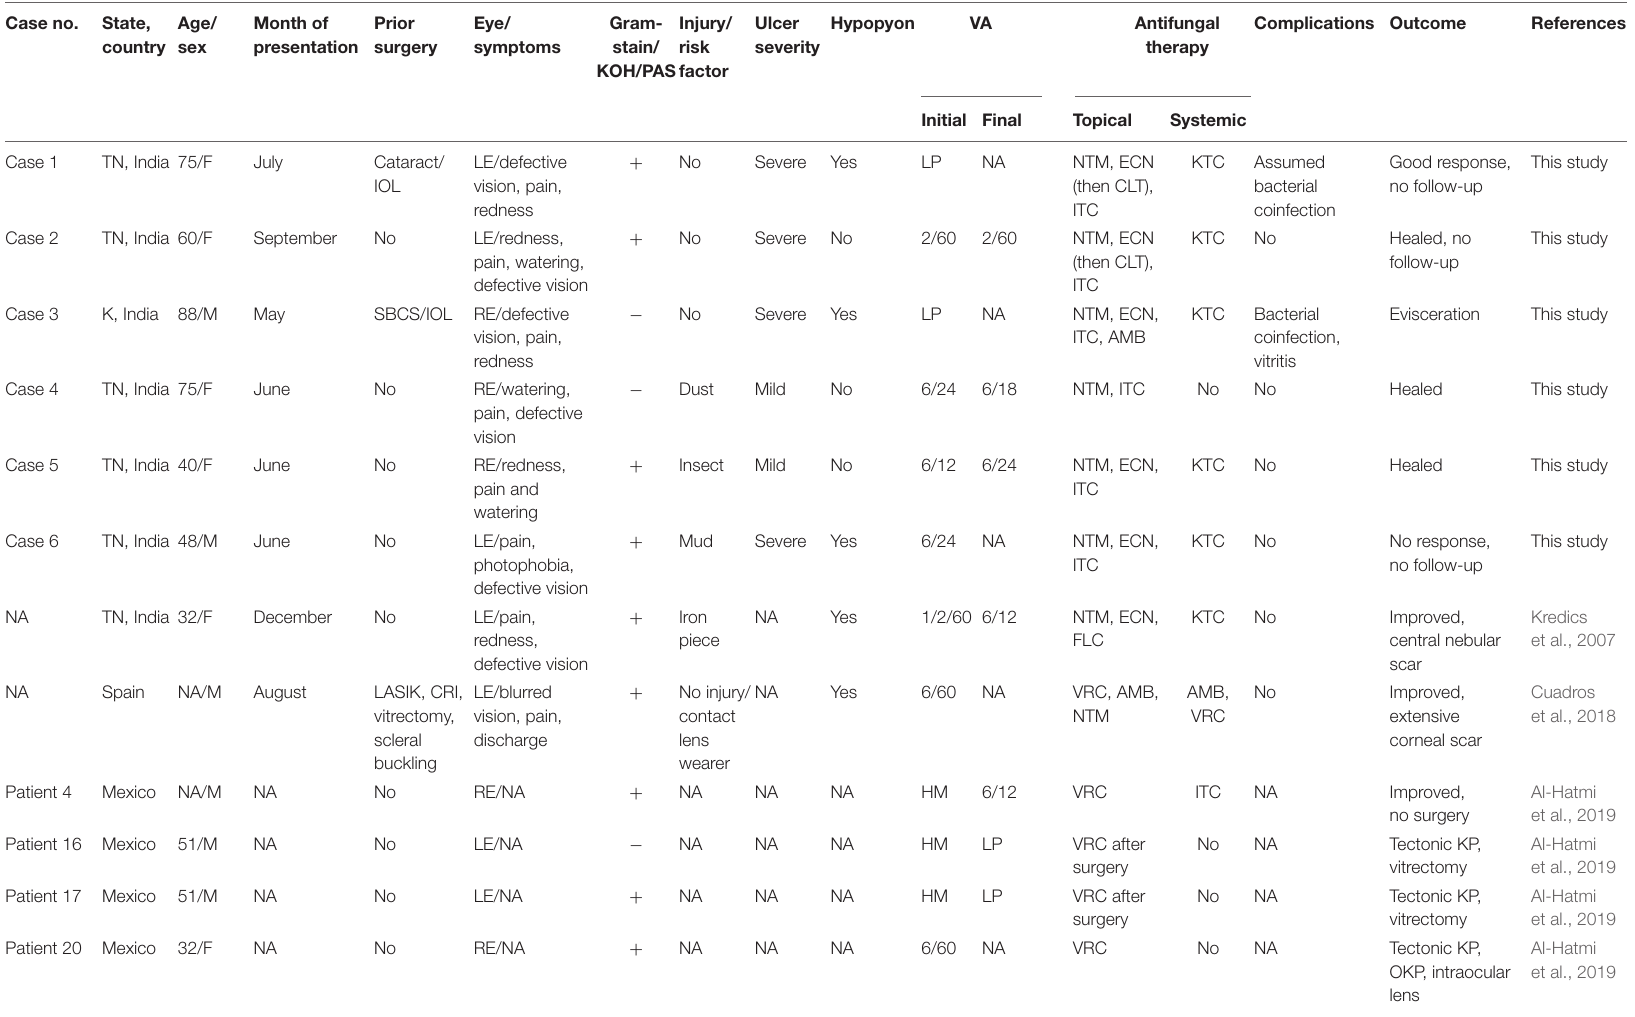
TABLE 2 | Detailed characteristics of the six newly presented cases of keratitis caused by Aspergillus tamarii and their comparison to previously reported